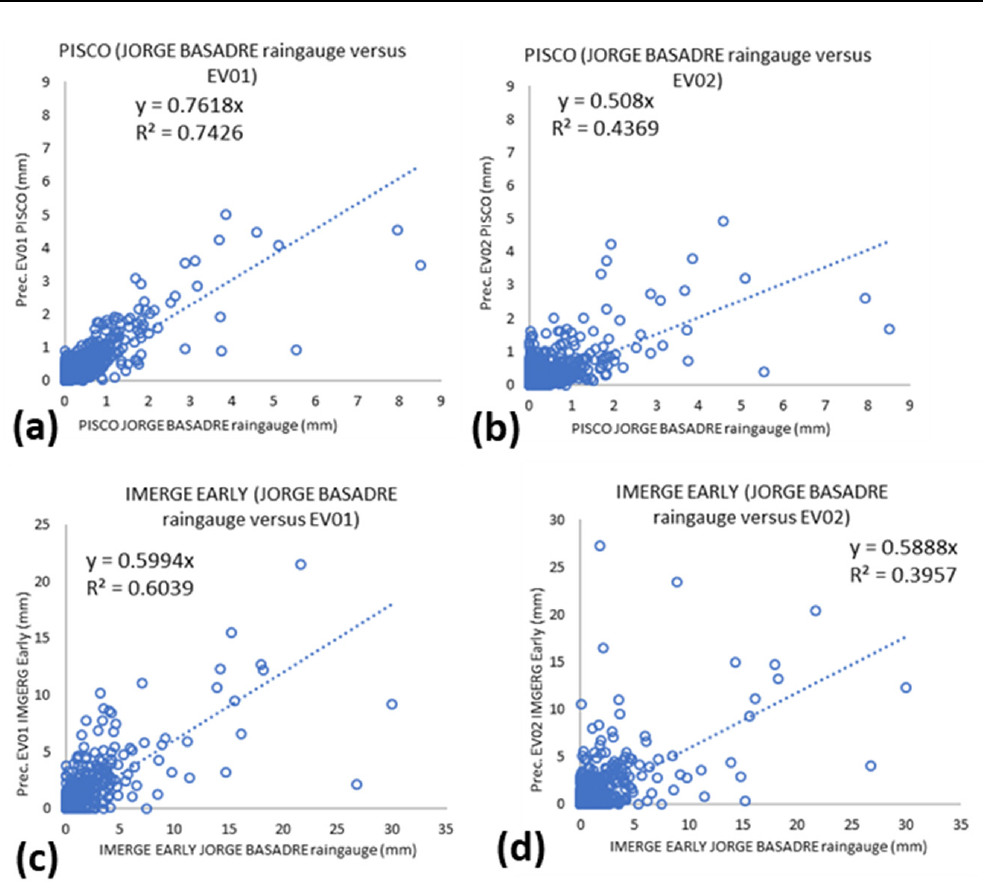
Figure 9. Correlations were made between the total daily precipitation data between the JORGE BASADRE rain gauge and the virtual rain gauges, (EV01 and EV02) using the products: ( a , b ) PISCO, ( c , d ) IMERGE Early, ( e , f ) IMERGE Final, and ( g , h ) CHIRPS. Concerning the CHIRPS product, the precipitation in the EV01 and EV02 zones was lower by 27% and 45%, respectively, in comparison to the JORGE BASADRE rain gauge. In summary, the previous results corroborate that the amount of precipitation in the Devil’s Creek was less than the amount of precipitation in the city of Tacna, during the period of common observation between them. Table 4 shows a summary table of the linear regression coefficients obtained in the comparison of the data series. It is observed that the area of the EV01 virtual rain gauge,